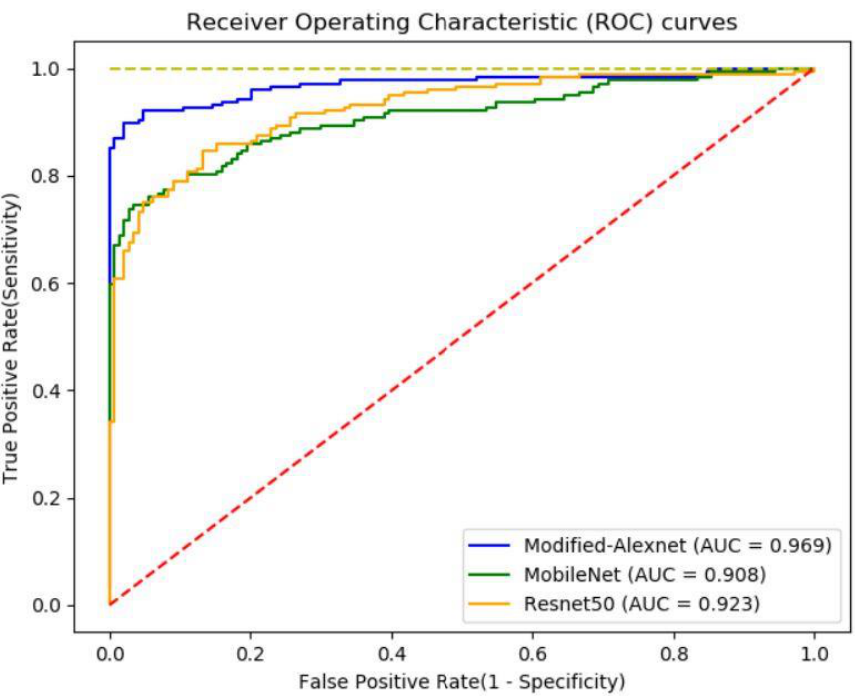
Figure 4. Mean ROC curves of three deep convolutional neural network (DCNN) models used in this study.